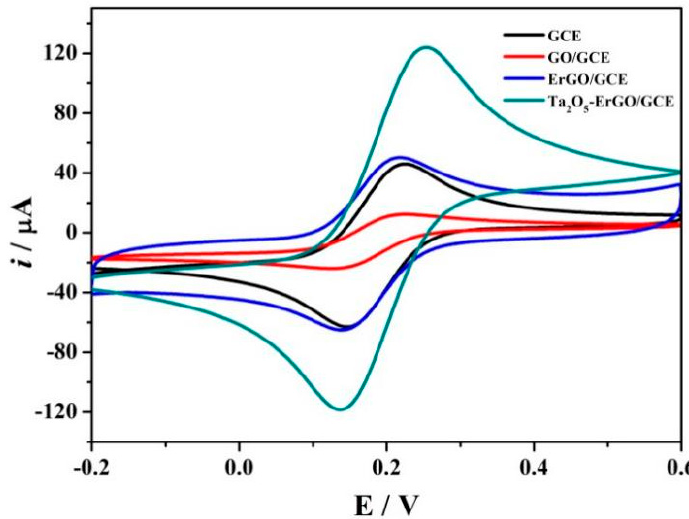
Figure 3. Cyclic voltammetry (CV) obtained on bare GCE, GO / GCE, ErGO / GCE, and Ta 2 O 5 -ErGO / GCE in a 5.0 mM K 3 Fe(CN) 6 solution and 0.1 M KCL at the scan of 0.1 V s − 1 .